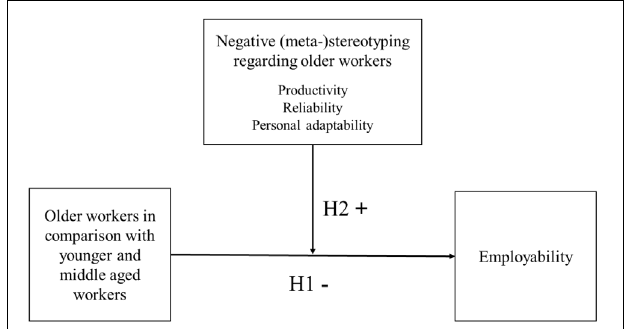
FIGURE 1 | Conceptual model presenting the moderating role of negative (meta-)stereotyping regarding older workers in the relationship between older age group membership and self-perceived